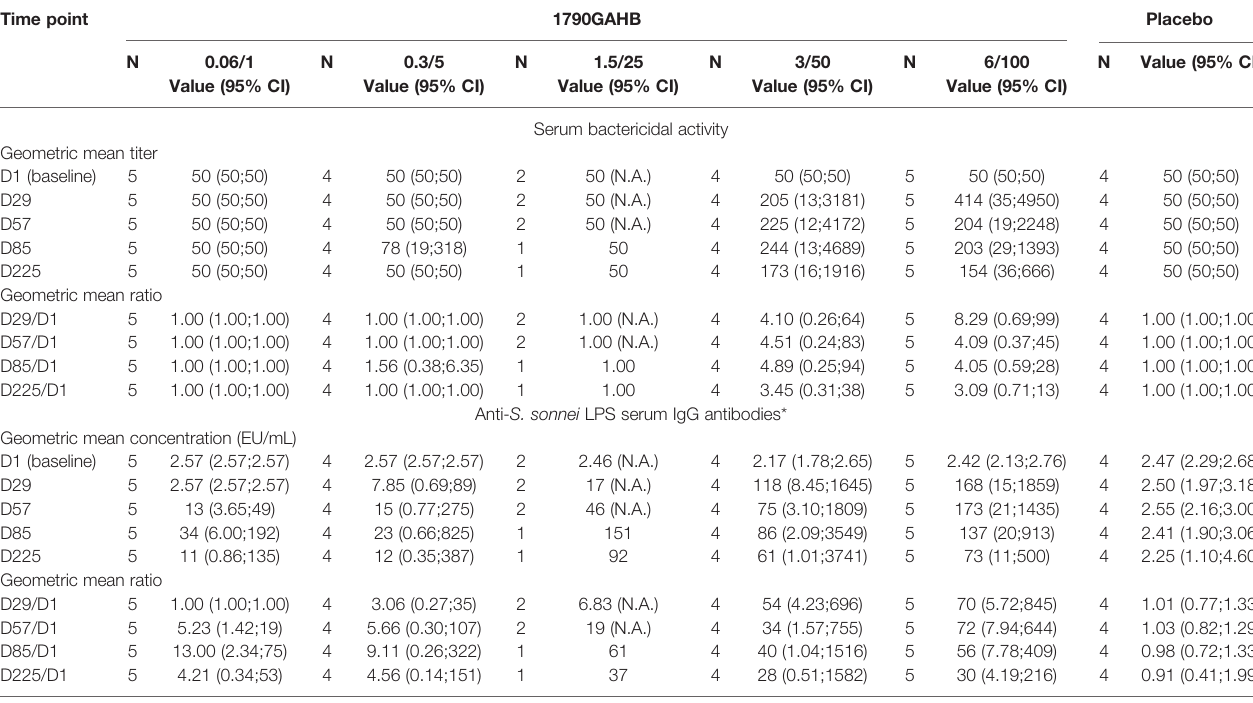
TABLE 1 | Serum bactericidal activity geometric mean titers, anti- S. sonnei LPS serum IgG geometric mean concentrations, and within-group geometric mean ratios in participants of the parent study who had baseline antibody levels below the lower limit of quanti fi cation for ELISA (modi fi ed full analysis set). Time point